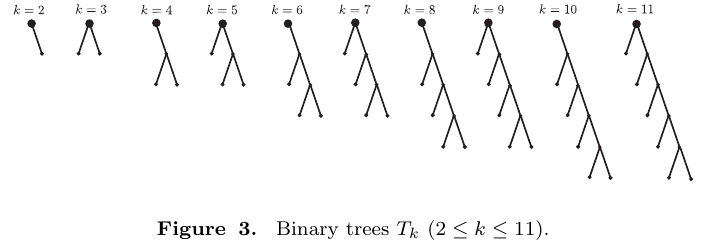
Figure 3. Binary trees T k (2 ≤ k ≤ 11).